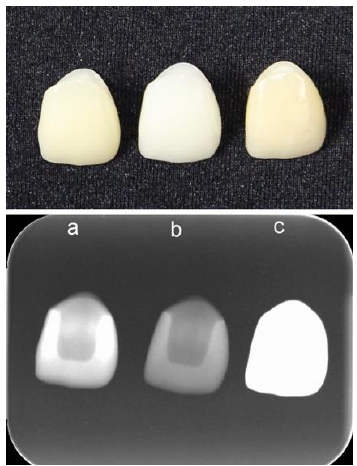
Figure 9. Logarithm of X-ray optical density of NanoZR, 3Y-TZP, cpTi (commercially pure tita- nium), alumina, and aluminum as a function of thickness. Reprinted with permission from Ref. [32]. 2010 Yuji Okuda.